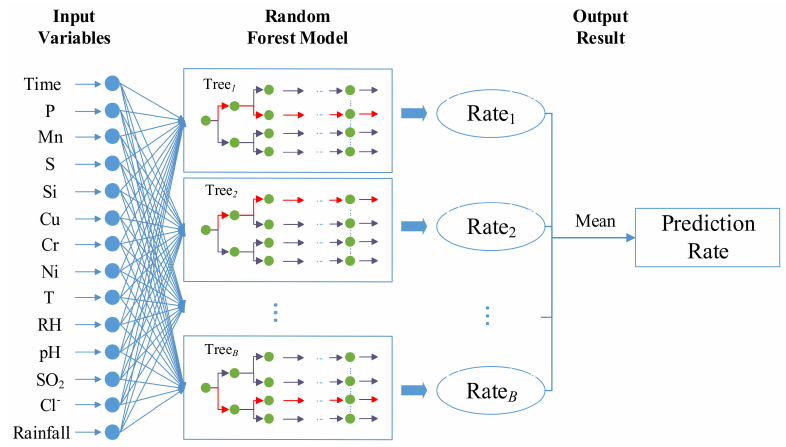
Figure 5. The process of forecasting the corrosion rate based on the Random Forest (RF)